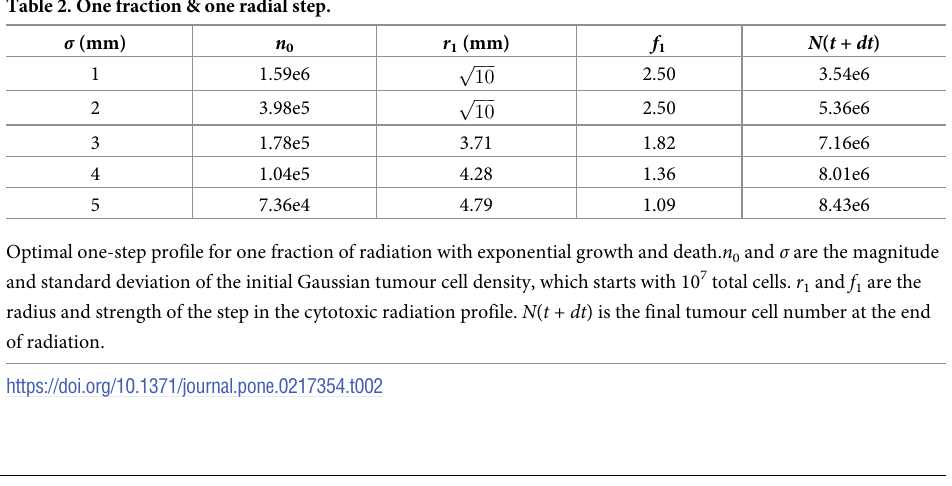
Table 2. One fraction & one radial step.